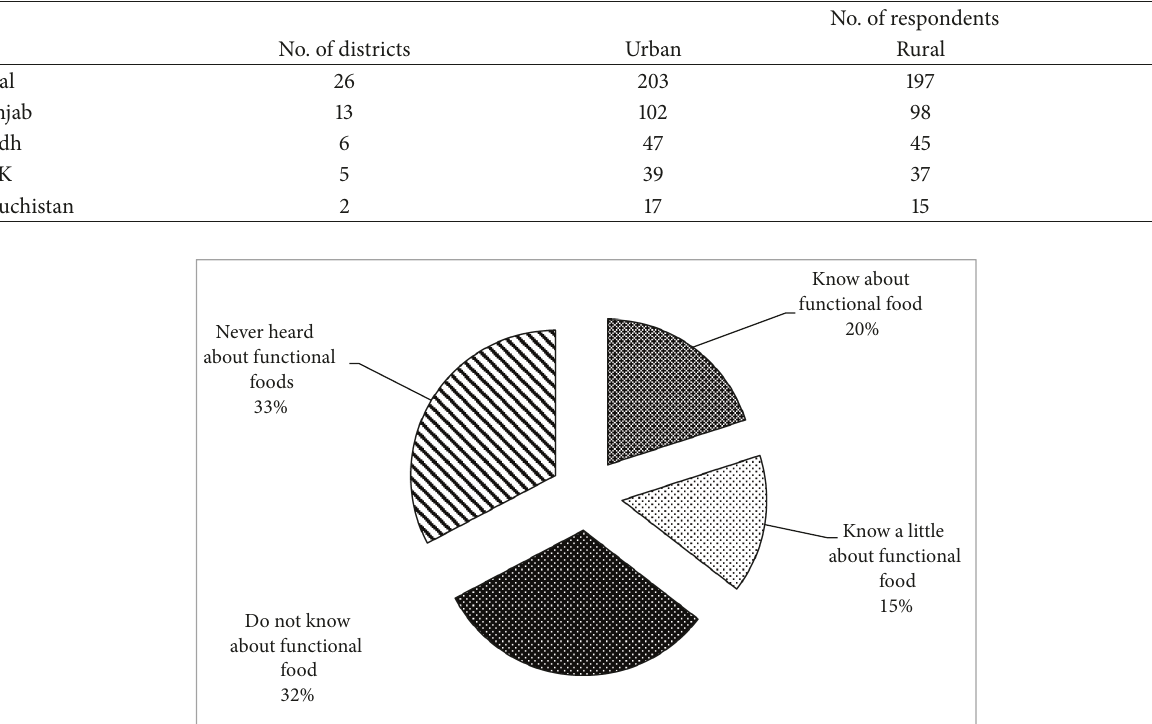
Table 1: Distributions of the respondents by province, rural, and urban areas.